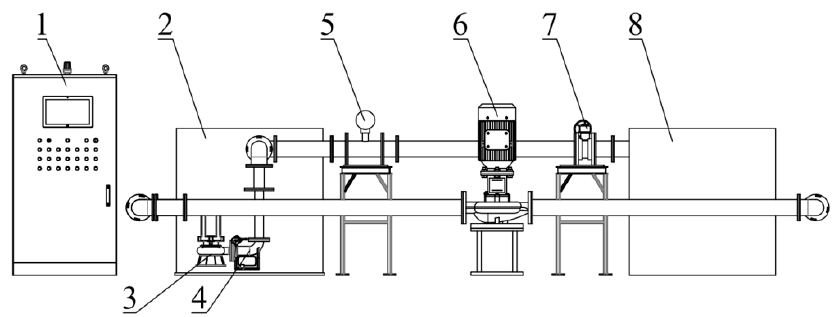
Figure 12. Sketch of centrifugal prefabricated pumping station test bench. 1. PLC variable frequency control cabinet; 2. round prefabricated barrels; 3. submersible centrifugal pump; 4. couplers; 5. electromagnetic flowmeter; 6. pipe pump; 7. turbo butterfly valve; 8. backflow tank.